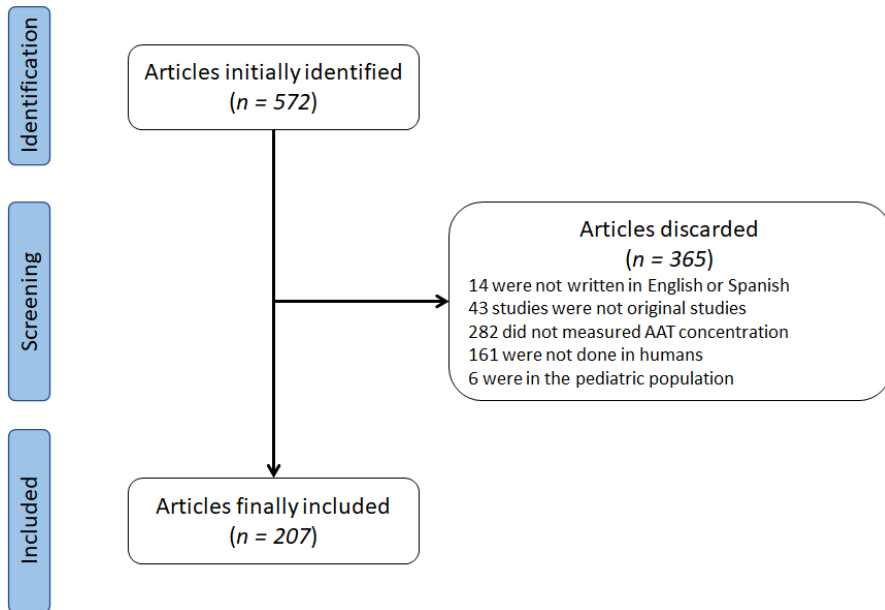
Figure 1. Flowchart of identification of studies. Table 1. Laboratory techniques used in the revised